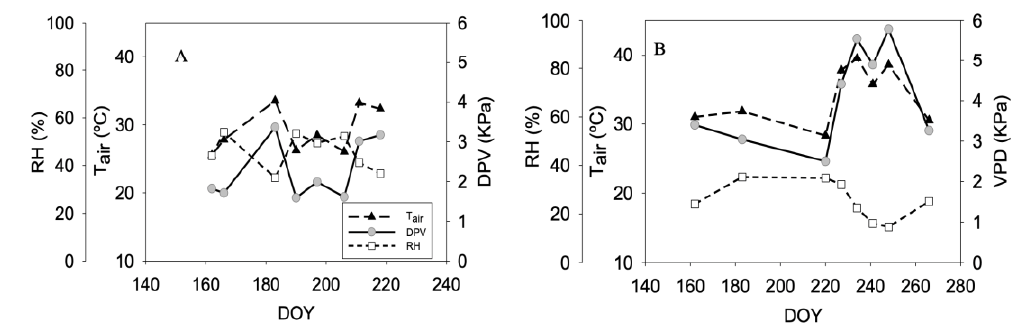
Figure 2. Meteorological conditions during the data collection in 2018 ( A ) and 2019 ( B ). T air , air temperature; RH, relative humidity; VPD, vapor pressure deficit; DOY, day of the year.